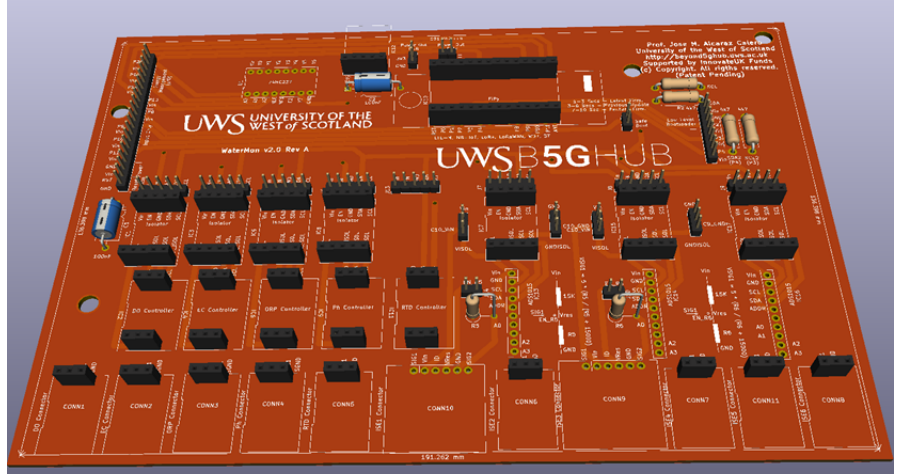
Figure 6. Three-dimensional Representation of